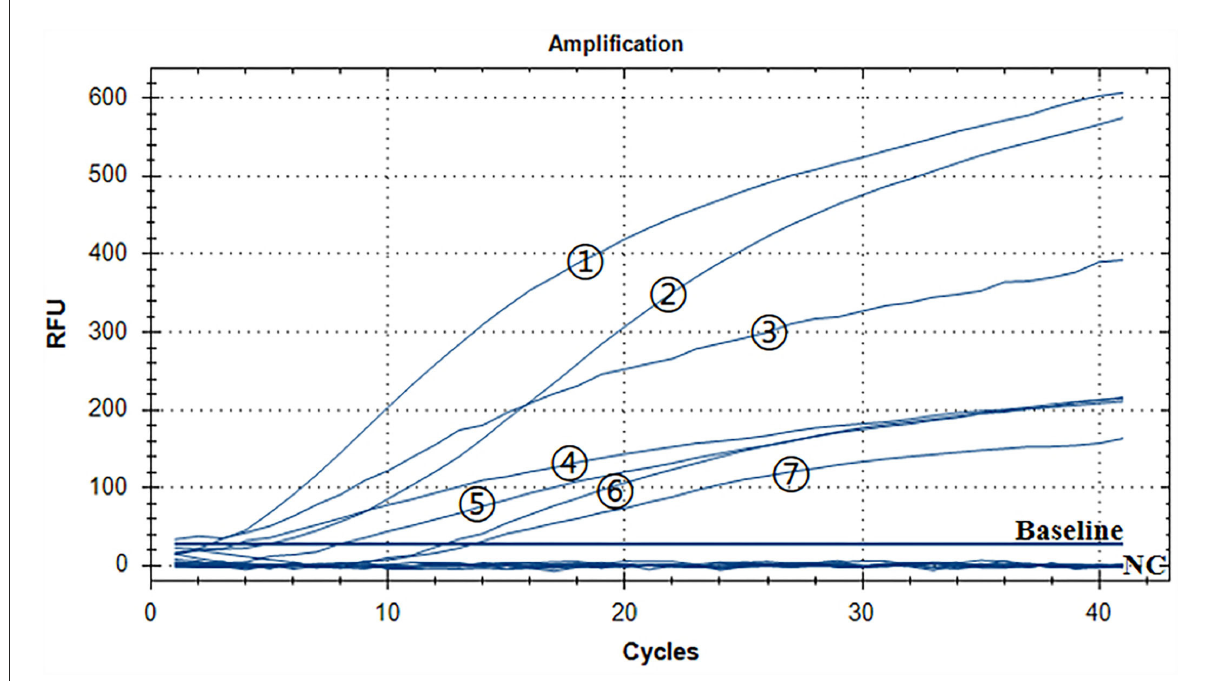
FIGURE4 Assay for the RT-RAA specificity. The positive control was ALV-A, B, C, D, E, J, and K nucleic acids, and the negative control was MDV, CAV, IBV, NDV, IBDV, H9N2, ILTV, and REV nucleic acids and ddH 2 O. ‹ - † respectively: ALV-J, ALV-K, ALV-A, ALV-D, ALV-E, ALV-C, and ALV-B.